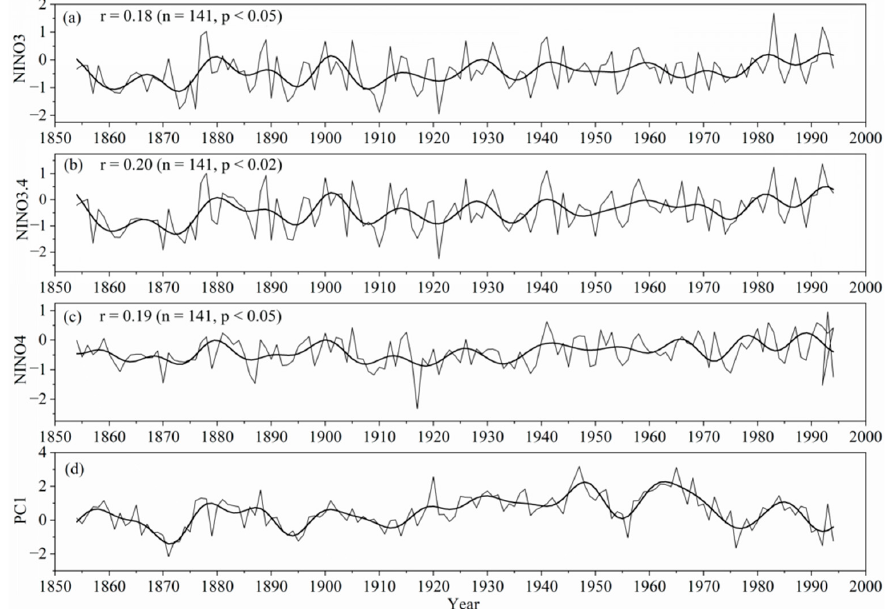
Figure 9. Comparison between the PC1 series ( d ) and the ( a ) NINO3, ( b ) NINO3.4, and ( c ) NINO4 anomalies. The thick lines depict 10-year low-pass filter series.